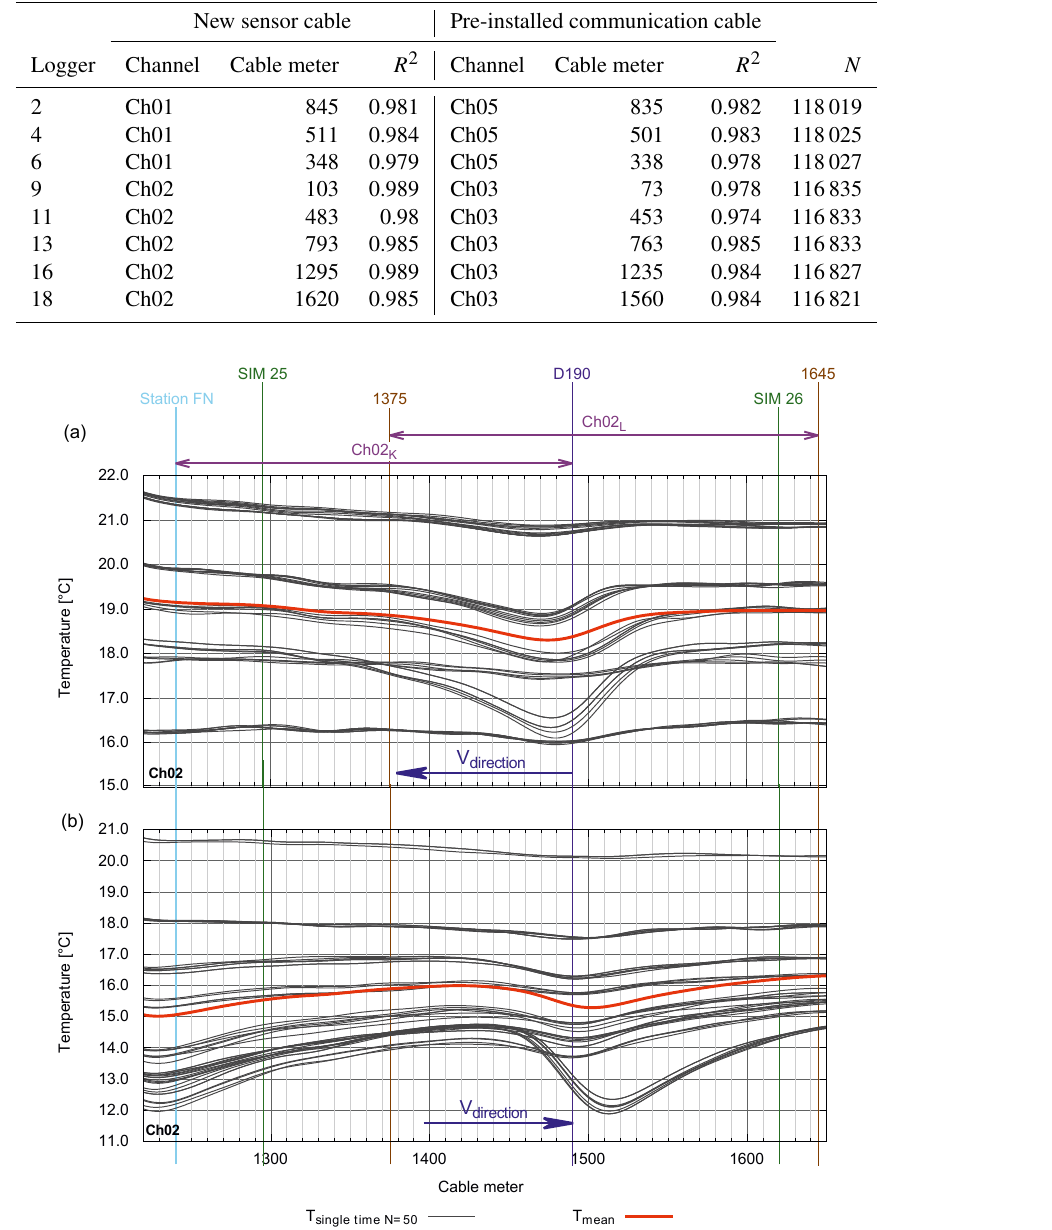
Figure 6. Temperature profile around emergency exit D190. (a) Randomly chosen operational breaks with observed wind direction towards station Franz-Neumann-Platz, (b) towards